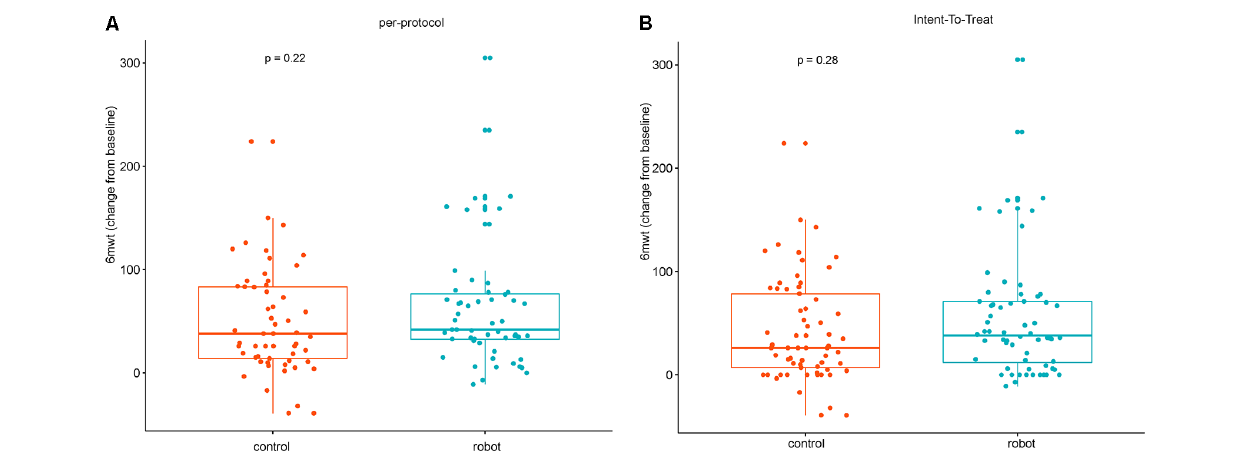
FIGURE 6 | Box plots of the changes in the 6-min walk test (6MWT) between groups after 4 weeks of treatment. (A) Per-protocol analysis. (B) Intent-to-treat analysis.